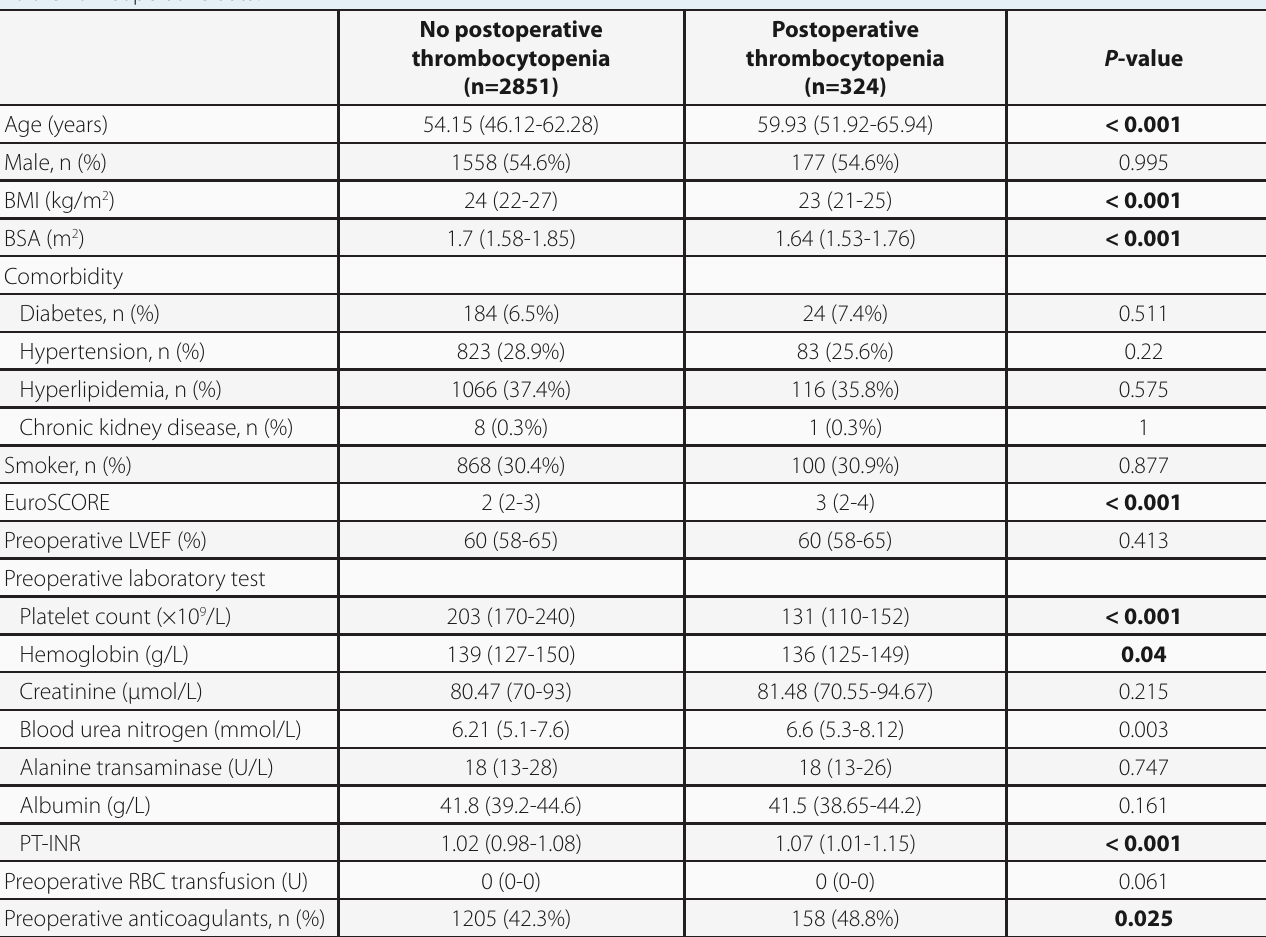
Table 1. Preoperative